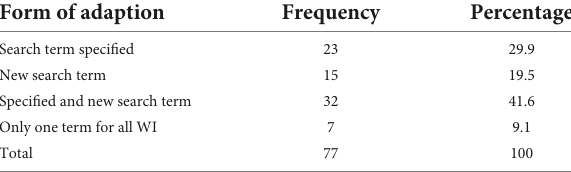
TABLE 3 Adaption of or using of new search term.